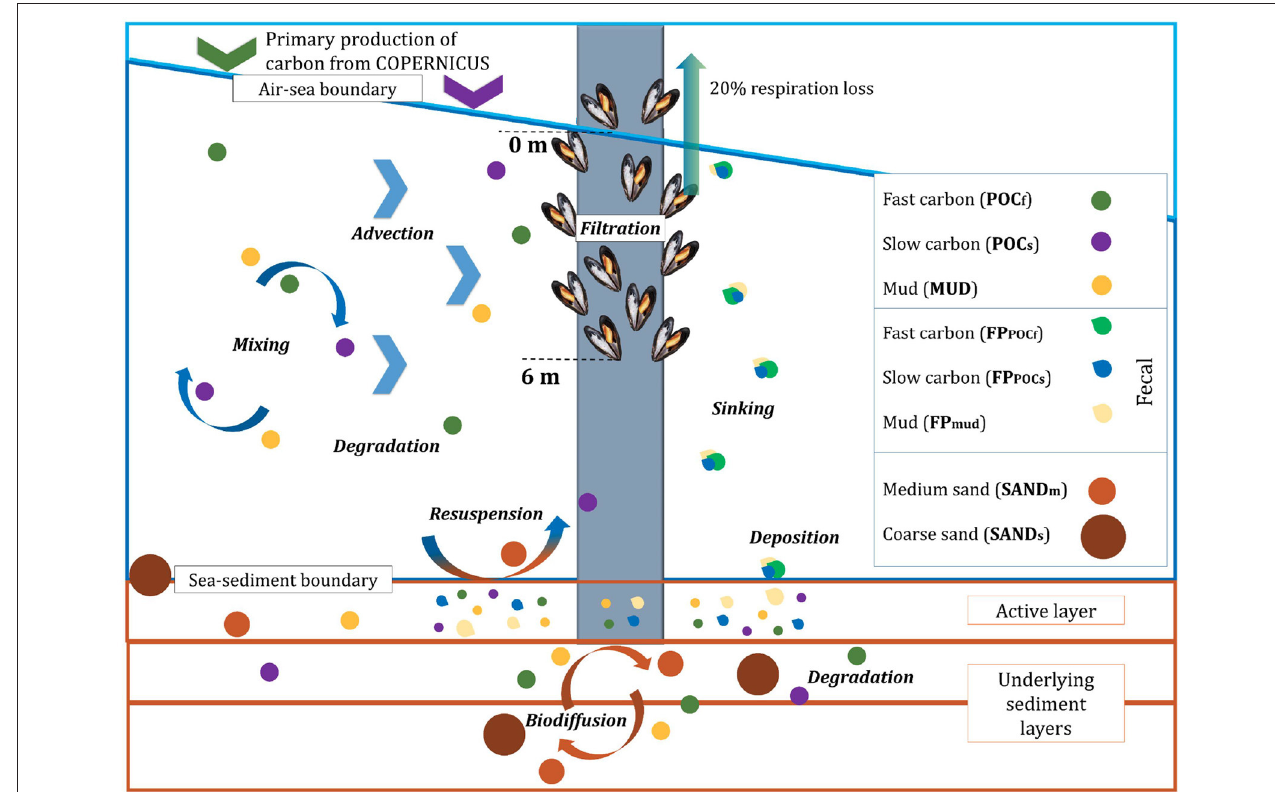
FIGURE 3 | Schematic representation of the carbon and mineral particle model including the filtration model. The filtration model describes the transformation of organic and inorganic materials into fecal pellets that sink to the bottom to feed the sedimentary